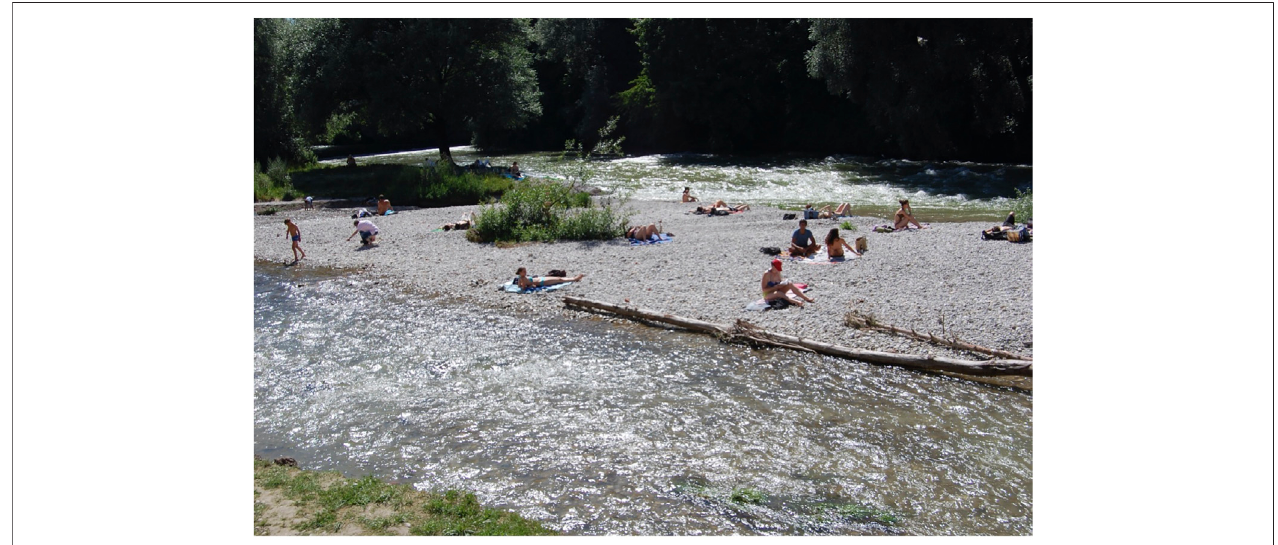
FIGURE 10 | Gravel added to the river is transported downstream and redeposited in large gravel bars that provide habitat for fi sh and wildlife, as well as recreational opportunities for the urban population, July 2012 (Photograph by Kondolf).